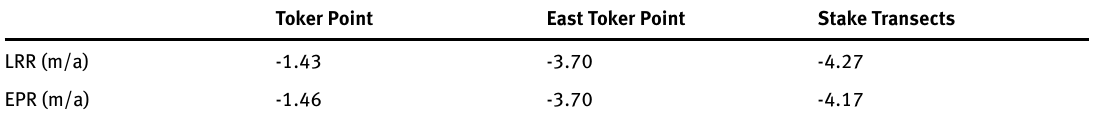
Table 1: Average erosion rate calculations for different zones within the study